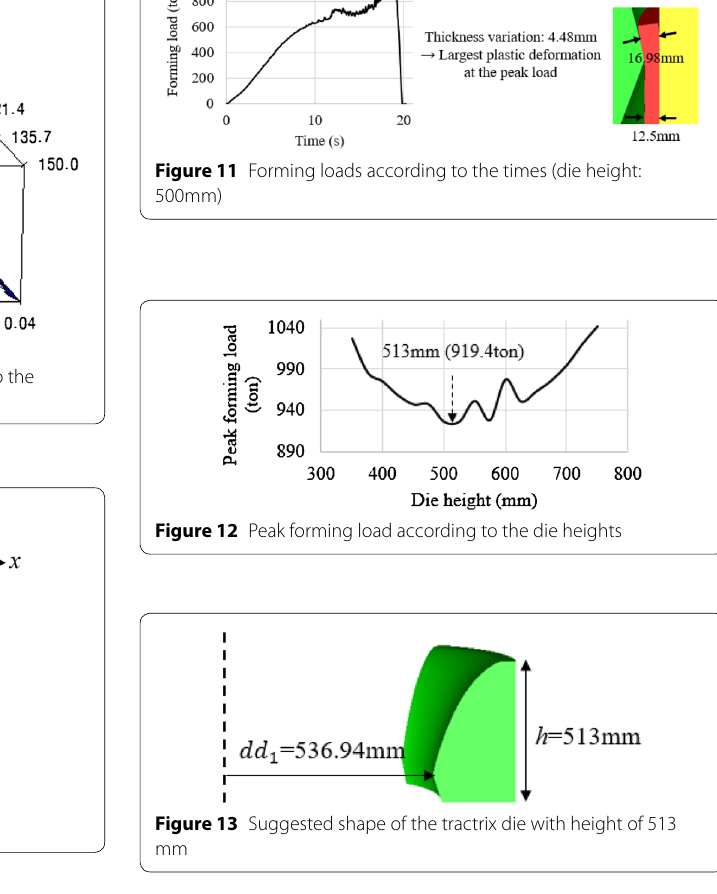
Table 3 Die height and inflow angle of material Die height (mm)